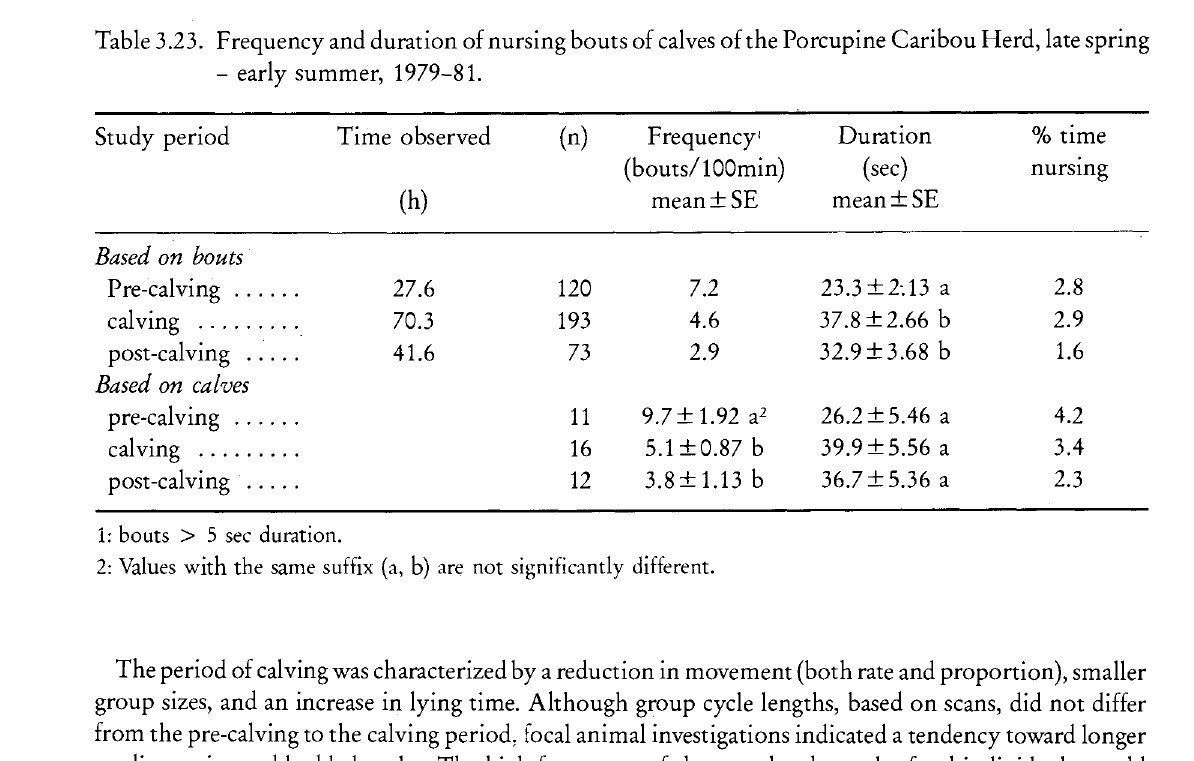
Table 3.23. Frequency and duration of nursing bouts of calves of the Porcupine Caribou Herd, late spring - early summer,